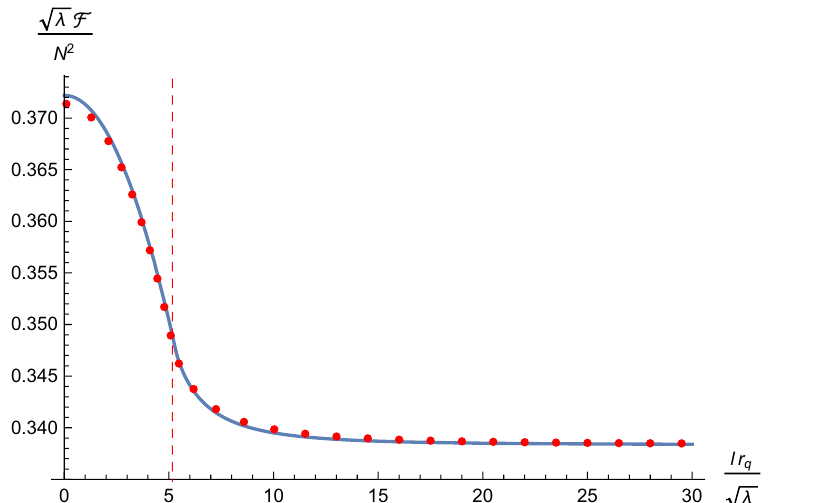
p (cid:21) ! 0) and p (cid:21) where l q is the